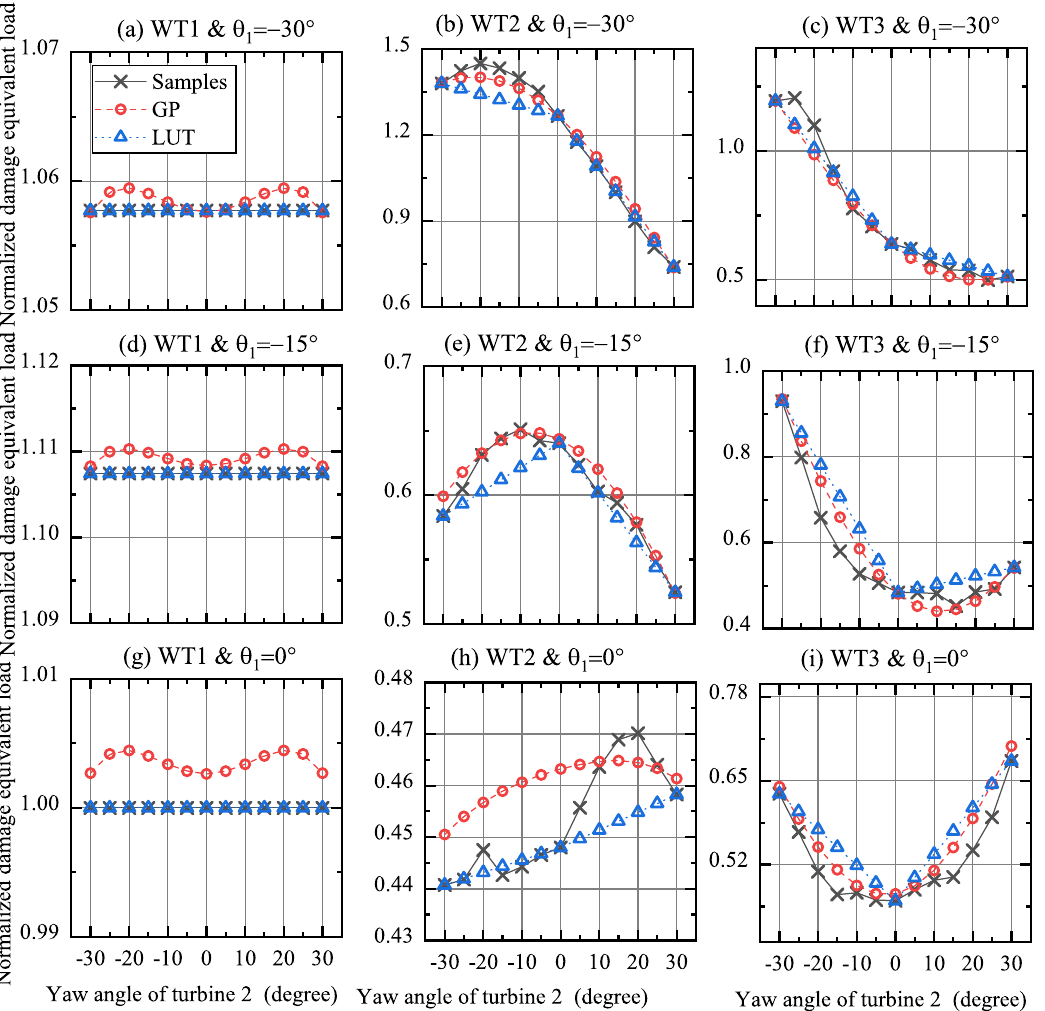
Figure 15. Prediction of normalized damage equivalent load at blade root flapwise moment under 9 m/s wind speed and 5% turbulence